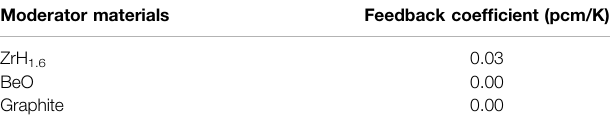
TABLE 6 | Moderator temperature feedback coef fi cient with different materials.